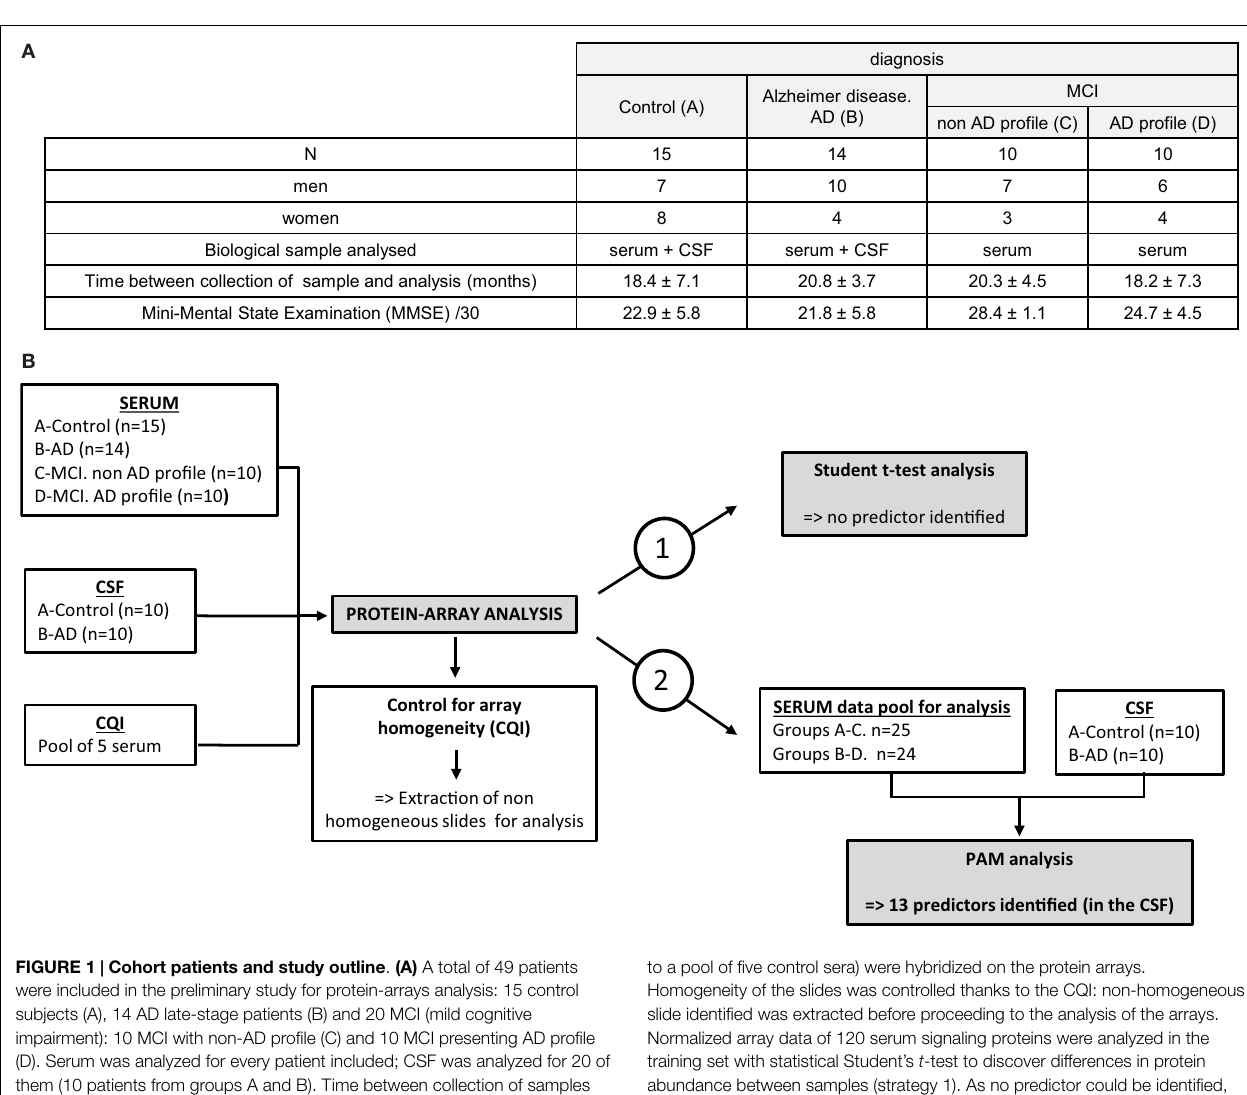
to a pool of five control sera) were hybridized on the protein arrays. Homogeneity of the slides was controlled thanks to the CQI: non-homogeneous slide identified was extracted before proceeding to the analysis of the arrays. Normalized array data of 120 serum signaling proteins were analyzed in the training set with statistical Student’s t -test to discover differences in protein abundance between samples (strategy 1). As no predictor could be identified, serum data were pooled for groups A–C and B–D (strategy 2). To discover predictors for classification, the training set was analyzed through prediction analysis for microarrays (PAM)